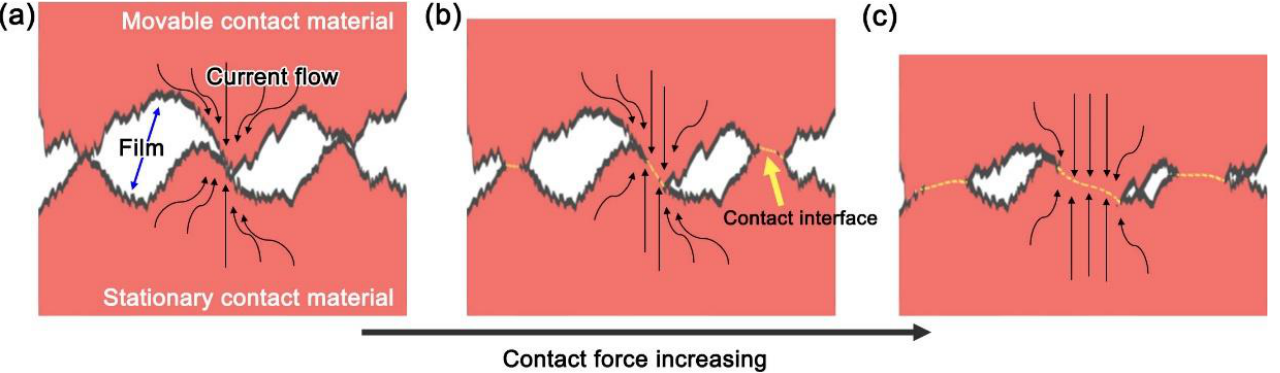
Figure 7. Schematic diagram of formation of contact resistance with increasing of the contact force. ( a ) Initial contact between the two contact materials, ( b ) Breakage of the film caused by increasing contact force, ( c ) Plastic deformation of the contact zone.